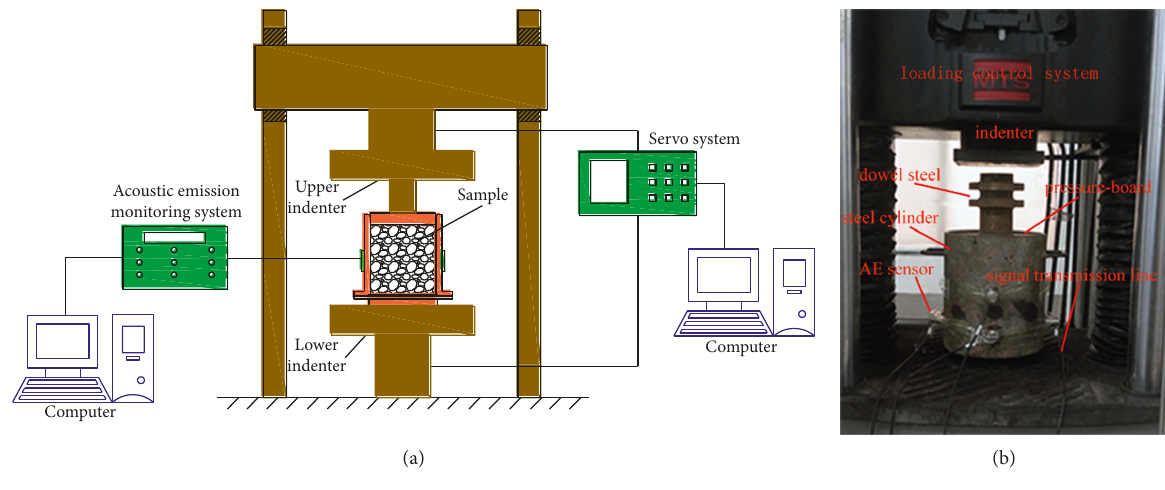
Figure 3: Experimental equipment.